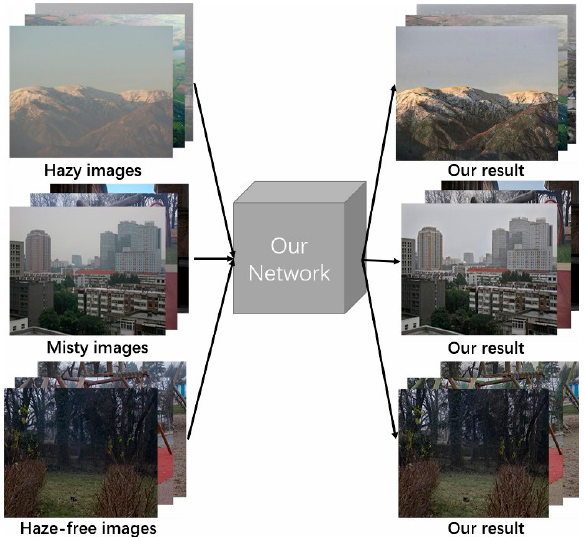
Figure 1. Our network can convert hazy images, misty images, and haze-free images into the results we